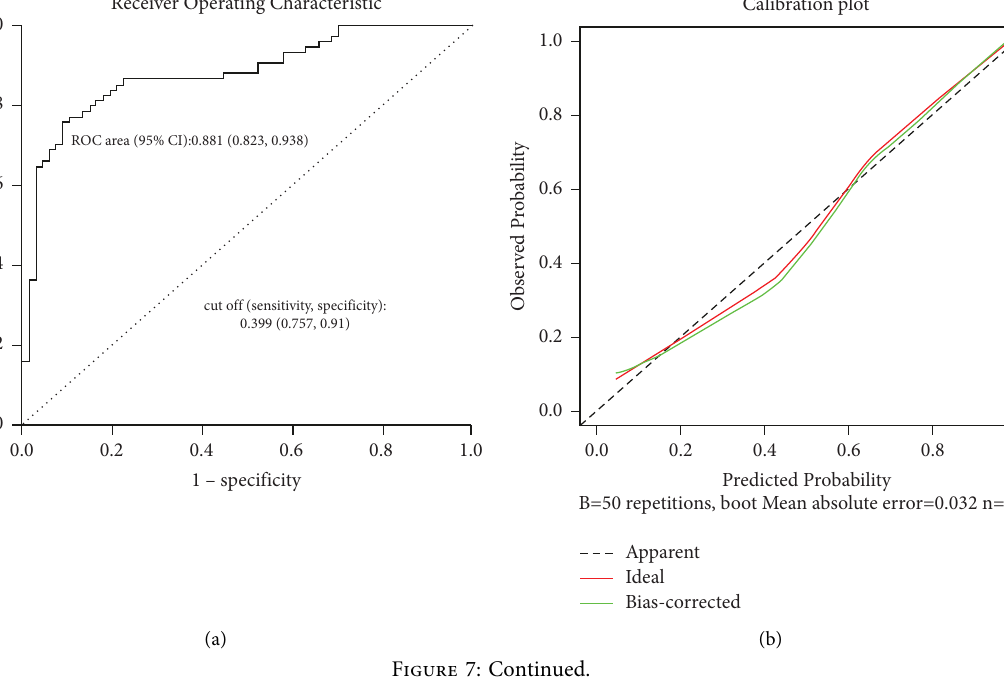
ROC area (95% CI):0.881 (0.823,